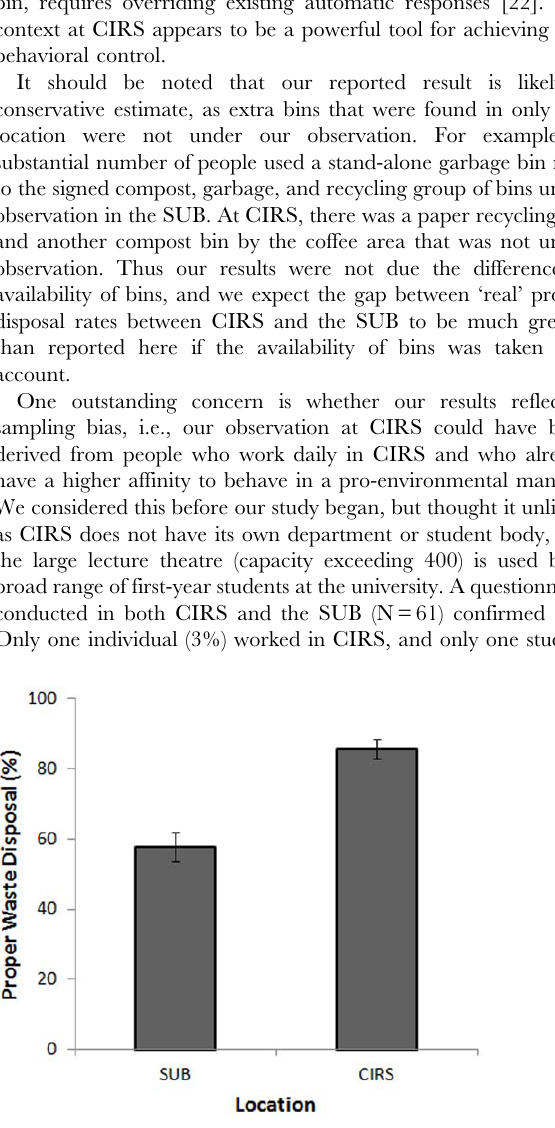
Figure 1. Percentage of proper waste disposal at the SUB or CIRS. People at CIRS (N=113) were significantly better at properly disposing waste, M =86%, compared to people at the SUB (N=116), M =58%. Error bars represent standard error of means.